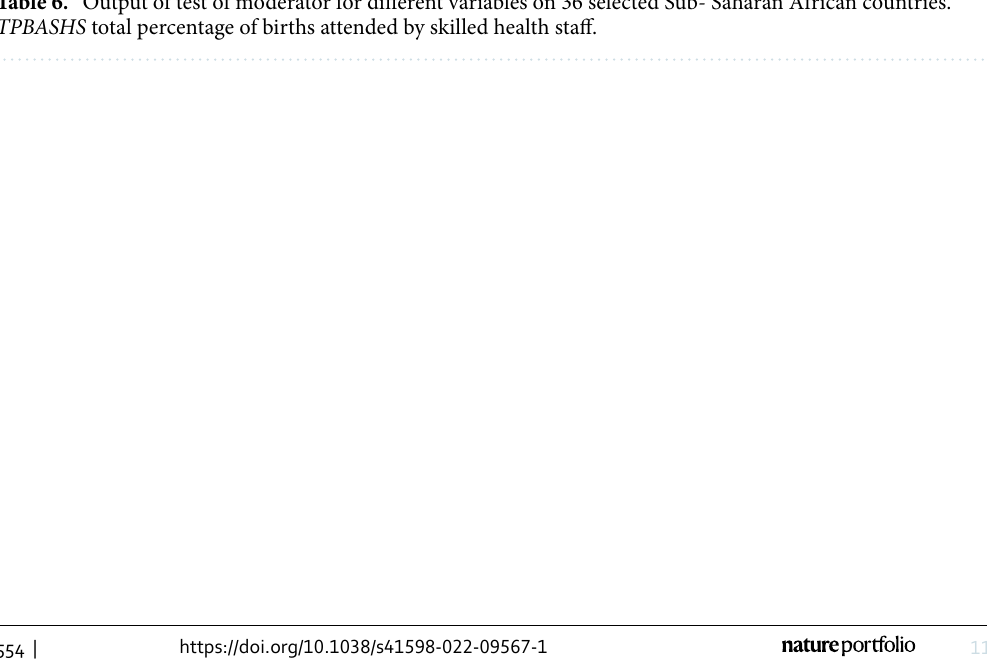
Table 6. Output of test of moderator for different variables on 36 selected Sub- Saharan African countries. TPBASHS total percentage of births attended by skilled health staff.